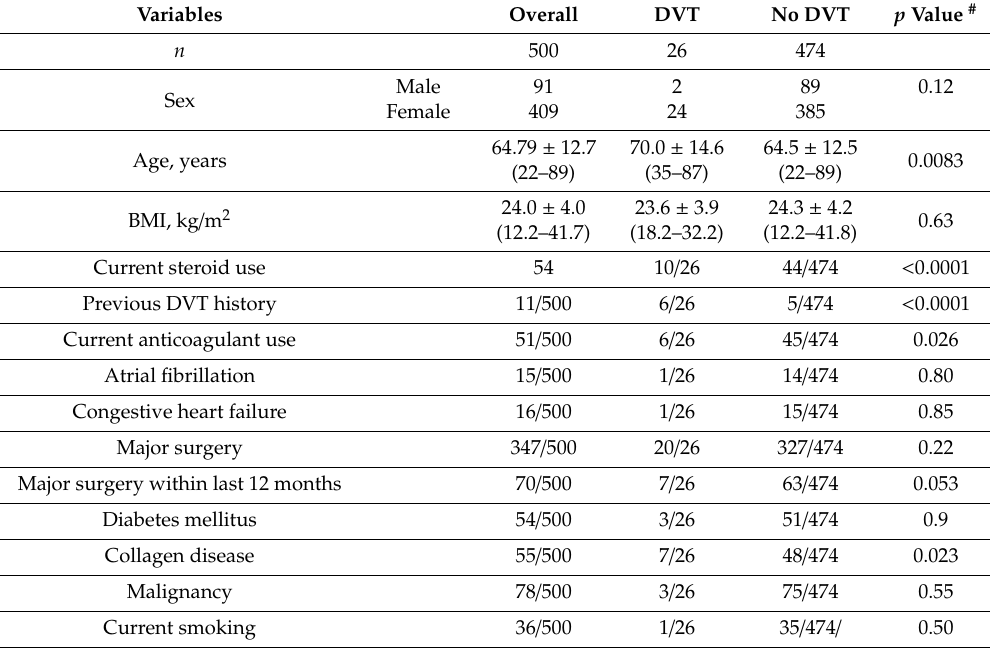
Table 1. Demographics of each group.